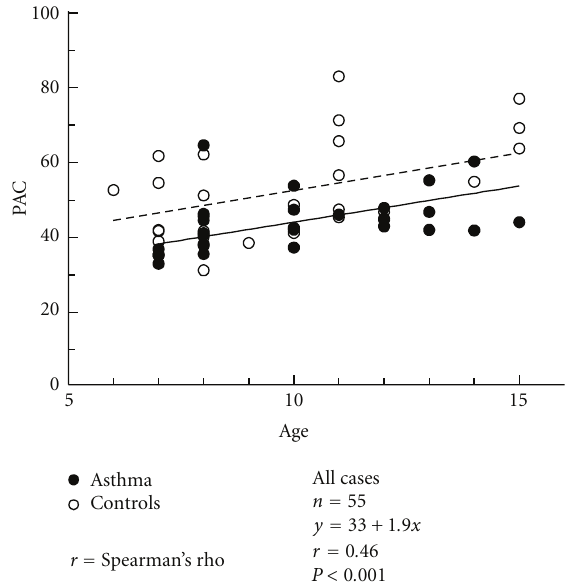
Figure 2: Baseline associations of PAC (mLO 2 /min/kg) by age (years) in asthmatic and control